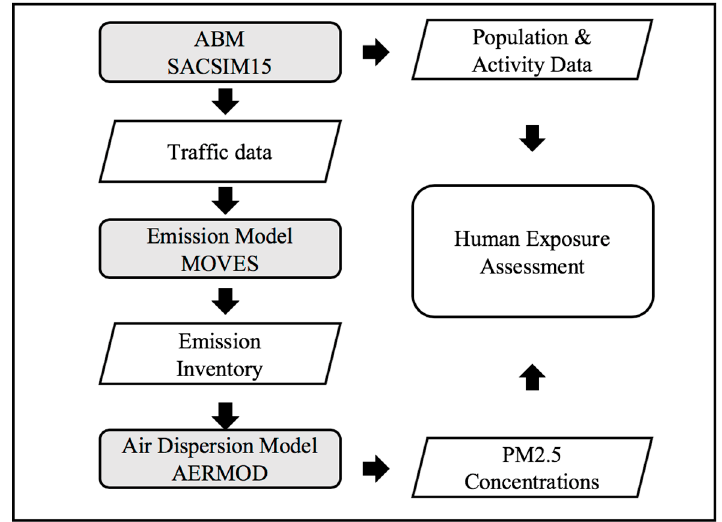
Figure 1. Overall dataflow of air quality model framework (grey rectangles represent models and white parallelograms represent data sets).